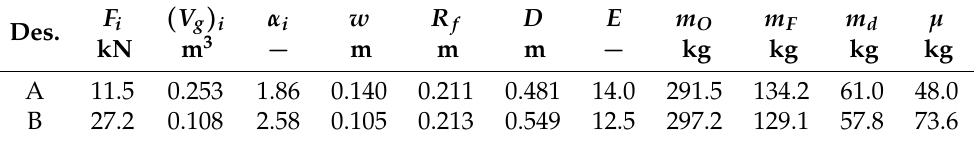
Table 10. Performance and design summary: deterministic optimization (800 km altitude). R f stands for the final grain burning distance, m F is the total fuel mass burned and m d is the engine dry mass.